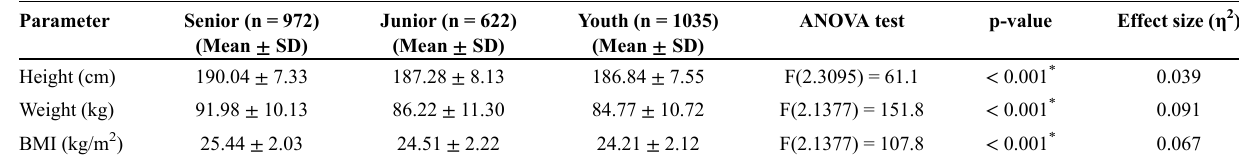
Table 1 - Descriptive (Mean ± SD) and comparative statistics of height, weight, body mass index between the three age categories. Between age cate- gories ANOVA for each parameter.